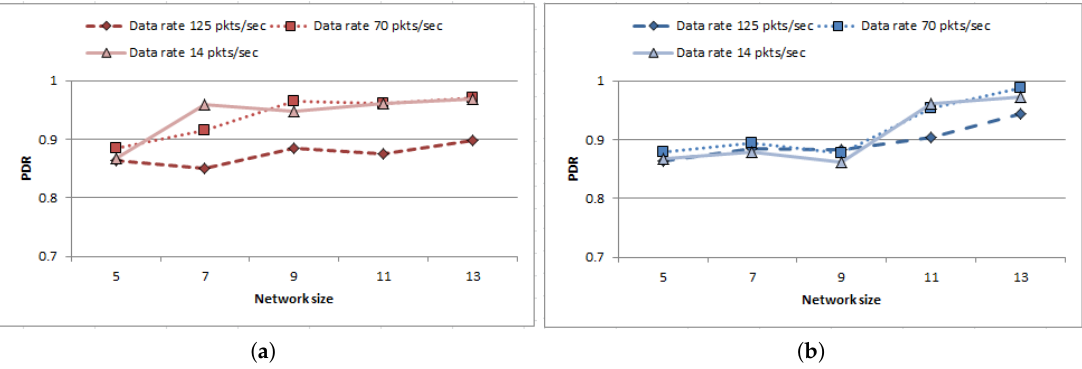
Figure 12. Reliability assessment of the proposed routing strategy in terms of Packet Delivery Ratio (PDR) with respect to growing network size. ( a ) Variation of PDR with growing network size following LMM. ( b ) Variation of PDR with growing network size following